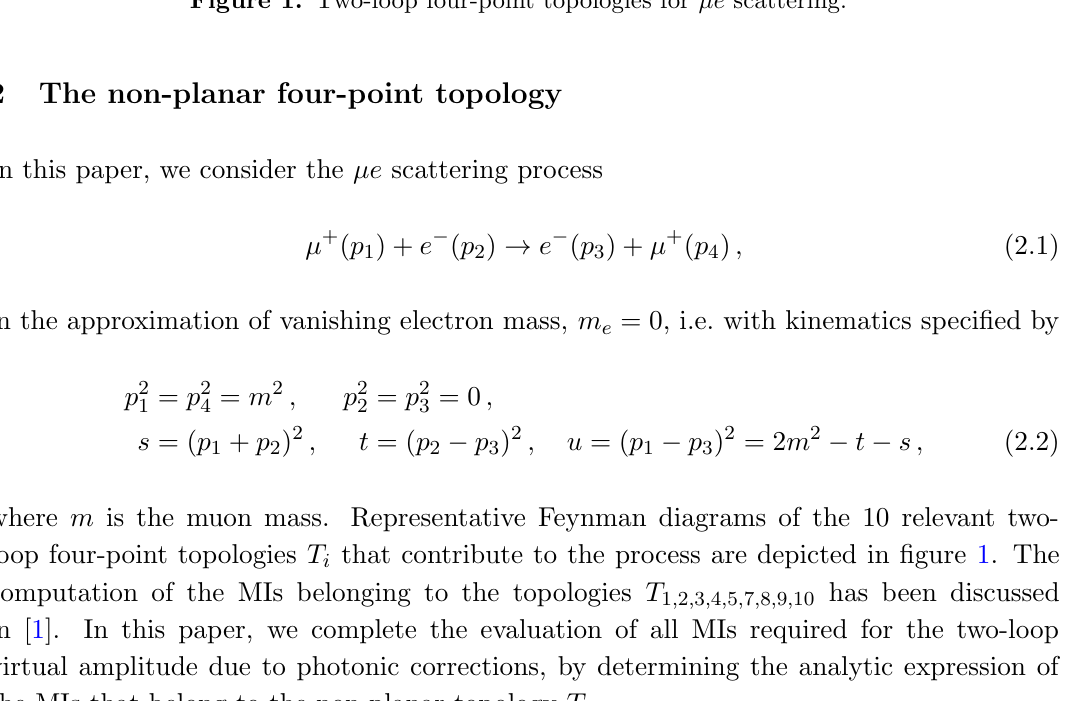
Figure 1. Two-loop four-point topologies for (cid:22)e